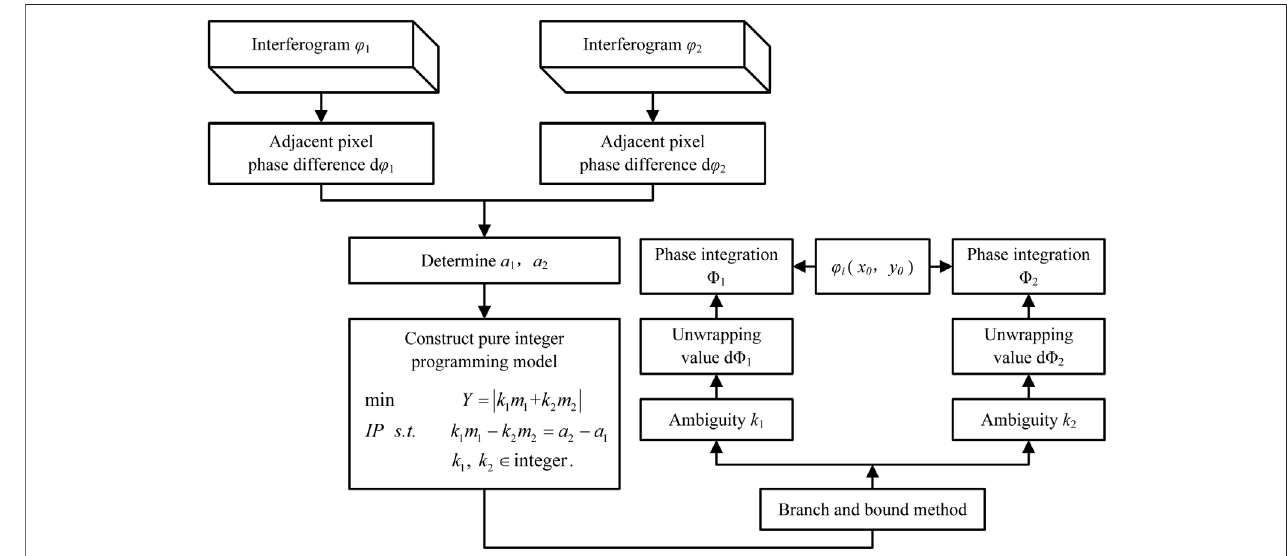
FIGURE 2 | Branch and bound PIP – PU process for dual-baseline